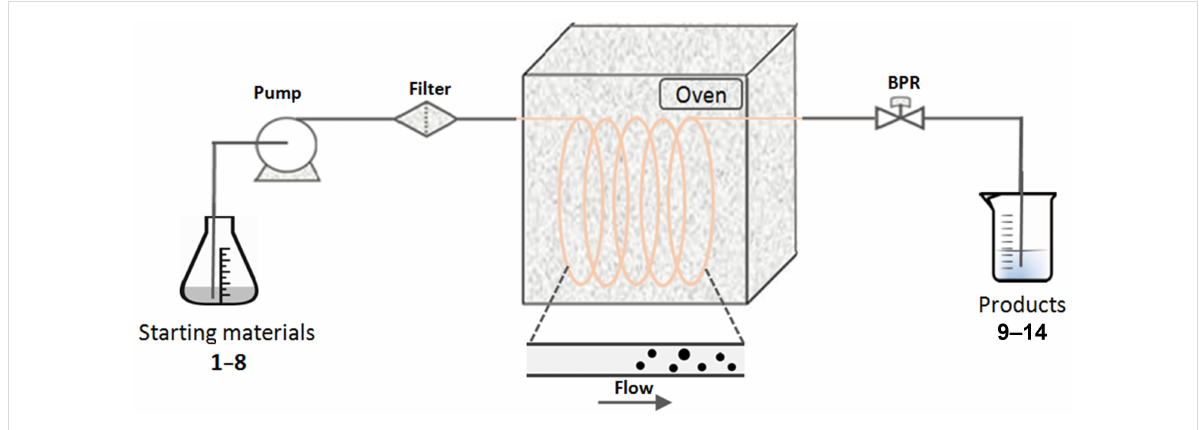
Figure 1: Schematic outline of the continuous-flow reactor.